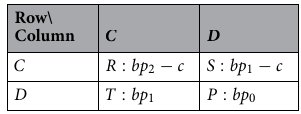
Table 2. Pay-off table of two-person weightlifting game.